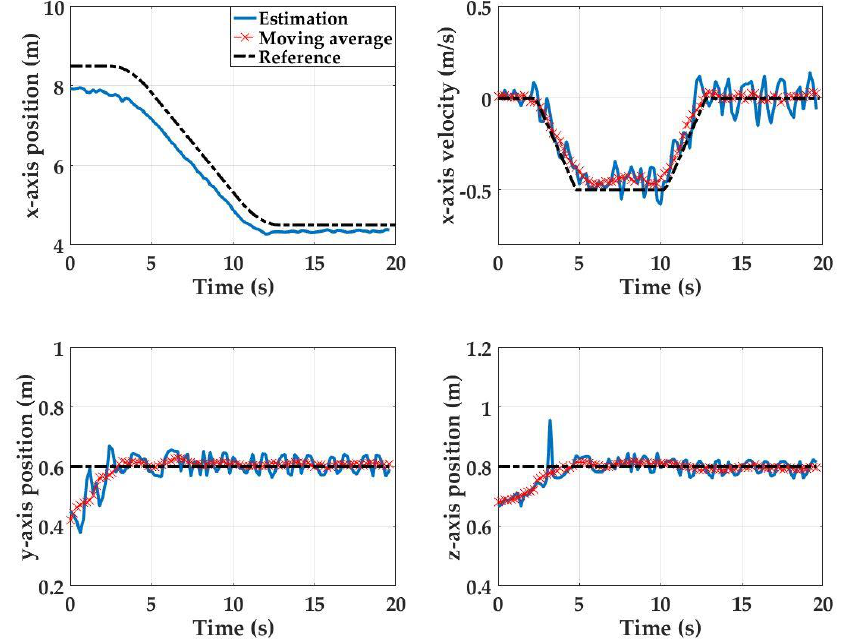
Figure 11. Empirical results for position estimations for Test 2: ( a ) reference and x -axis position estimate; ( b ) velocity reference and raw and smoothed velocity estimates; ( c ) raw and smoothed y -axis position estimates; and ( d ) raw and smoothed z-axis position estimates.